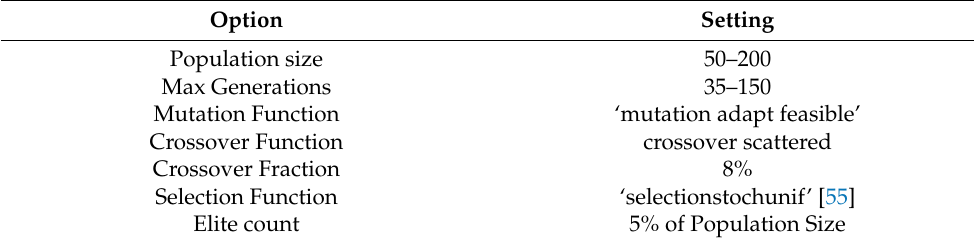
Table 4. Settings for the optimization using Genetic Algorithms.